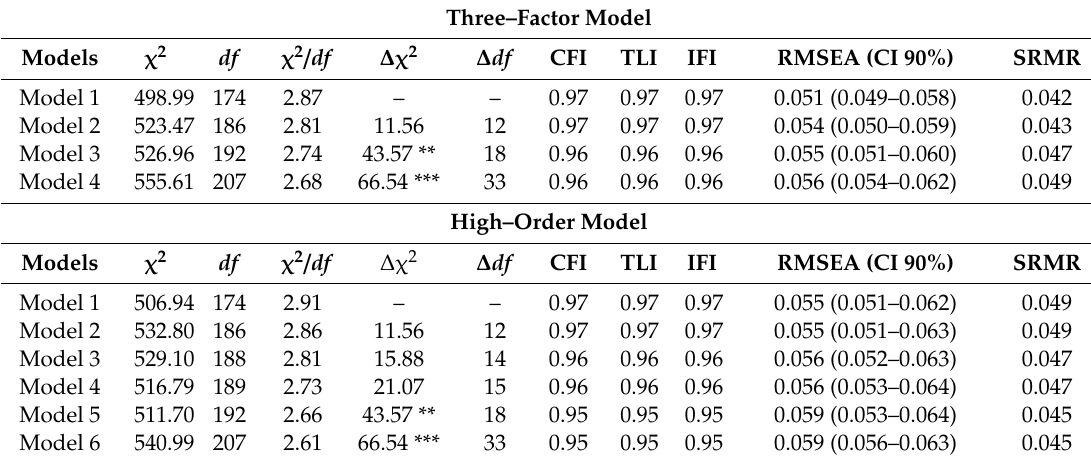
Table 3. Analysis of invariance by